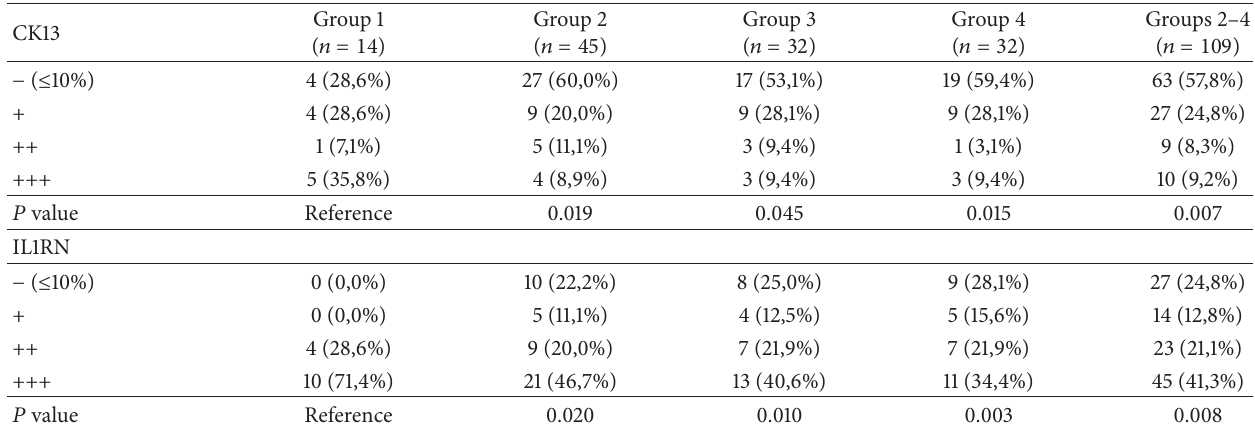
Table 2: Correlations between KRT13 and IL1RN expression and tumor characteristics in UCB tissue samples compared with controls. CK13